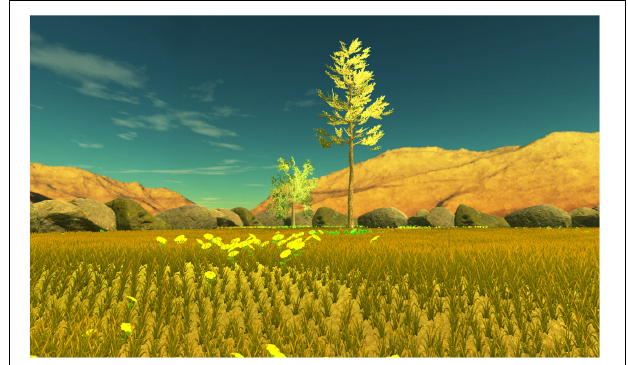
FIGURE 2 | The High Snow Mountains environment.